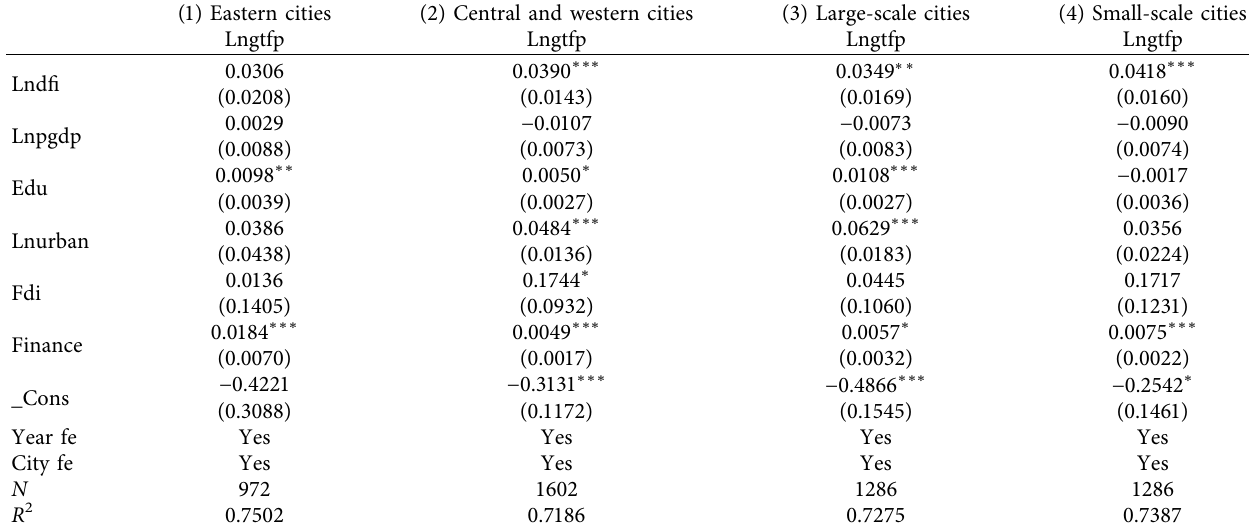
Table 7: Heterogeneity of digital finance influencing green